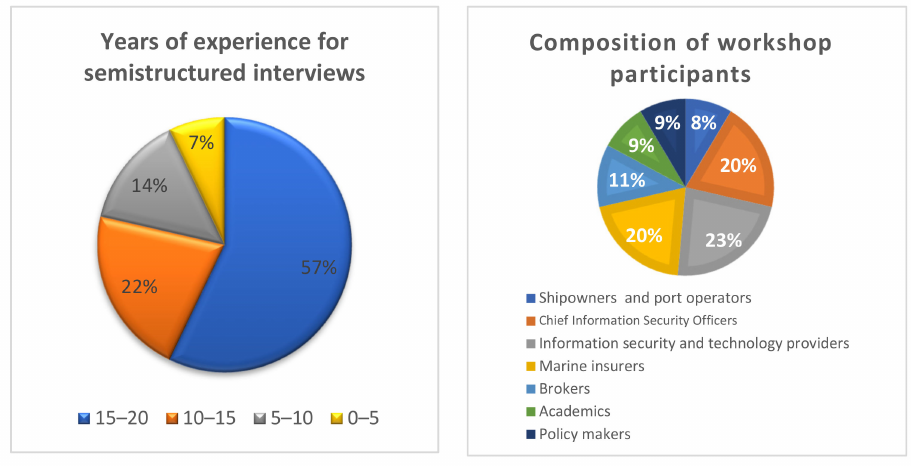
Figure 1. Participants’ data. Source: Authors.